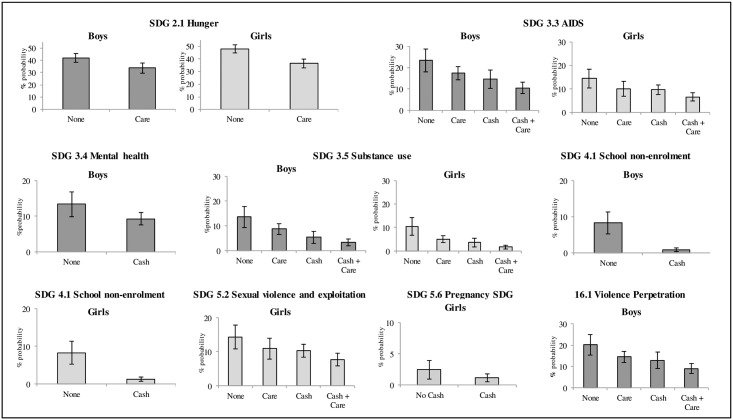
Predicted percent probabilities of SDG indicators when ‘cash,’ ‘care,’ ‘cash and care,’ or ‘no provision’ (‘none’) are received, holding all other covariates in the logistic regression model at their average levels (see Tables 2 and 3 for variables included in final predictive model for each outcome).Error bars indicate 95% confidence intervals.